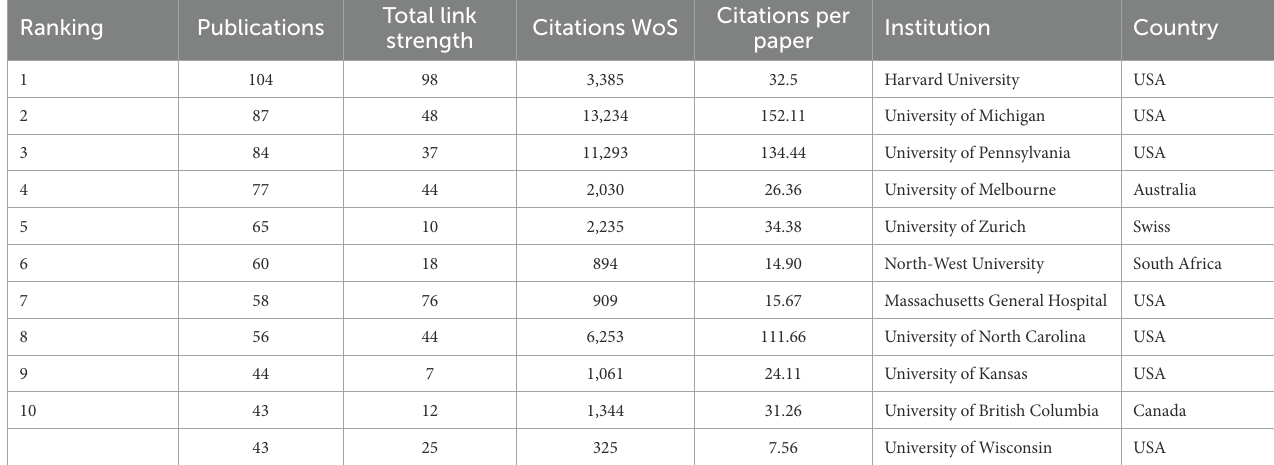
TABLE 2 Top 10 prolific institutions researching positive psychology.